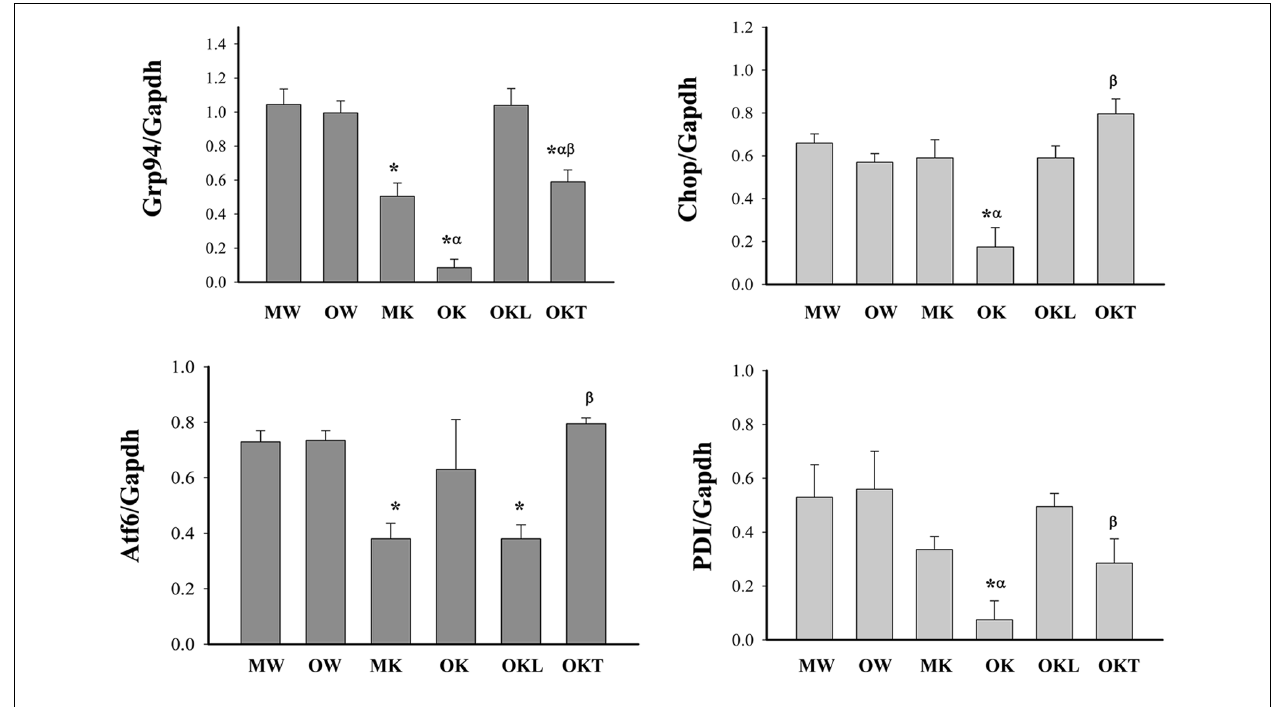
FIGURE 3 | Methylation of CpG islands of ER stress gene promoters in the livers of mice at different ages. Grp94, glucose-regulated protein 94; Gapdh, glyceraldehyde-3-phosphate dehydrogenase; Chop, DNA damage-inducible transcript 3, also known as C/EBP homologous protein; Atf6, activating transcription factor 6; PDI, protein disulfite isomerase; MW, wild type of middle age; OW, wild type of older age; MK, BiP knockout of middle age; OK, BiP knockout of older age